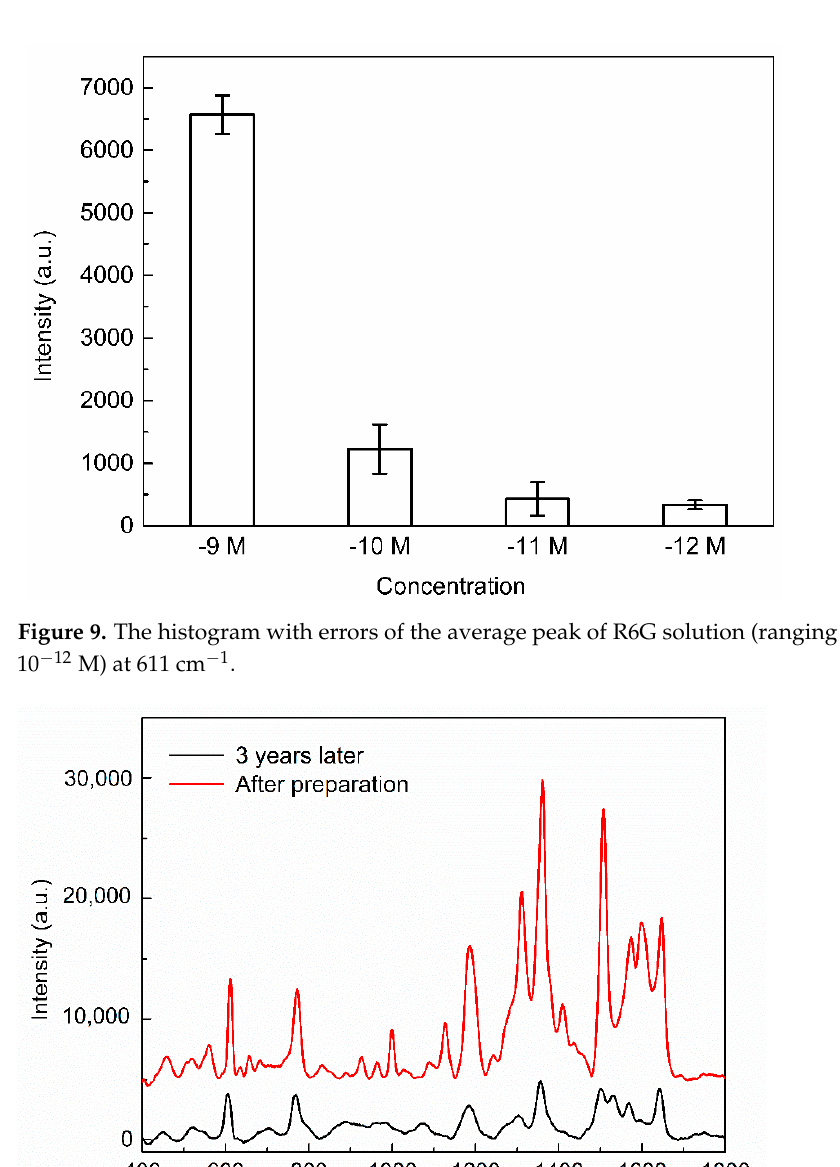
Figure 8. The SERS spectra of various concentrations of R6G solution (ranging from 10 (cid:2879)(cid:2877) M to 10 (cid:2879)(cid:2869)(cid:2871) M) gathered on Ag/IPS.